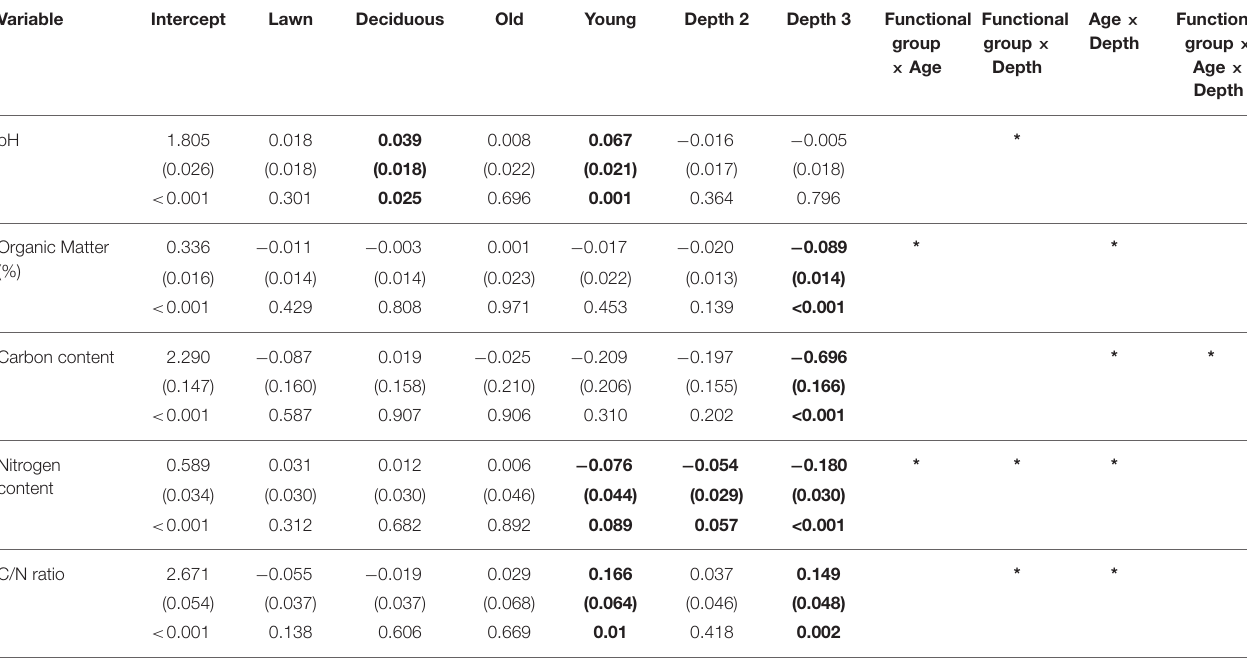
TABLE 1 | GLMM results, testing the effects of plant functional groups (evergreen trees, deciduous trees, lawns), park age (young, intermediate, old), soil depth (0–10, 11–20, and 21–50cm) and their two-way and three-way interactions on five variables (pH, % organic matter, Carbon content, Nitrogen content, and the C/N